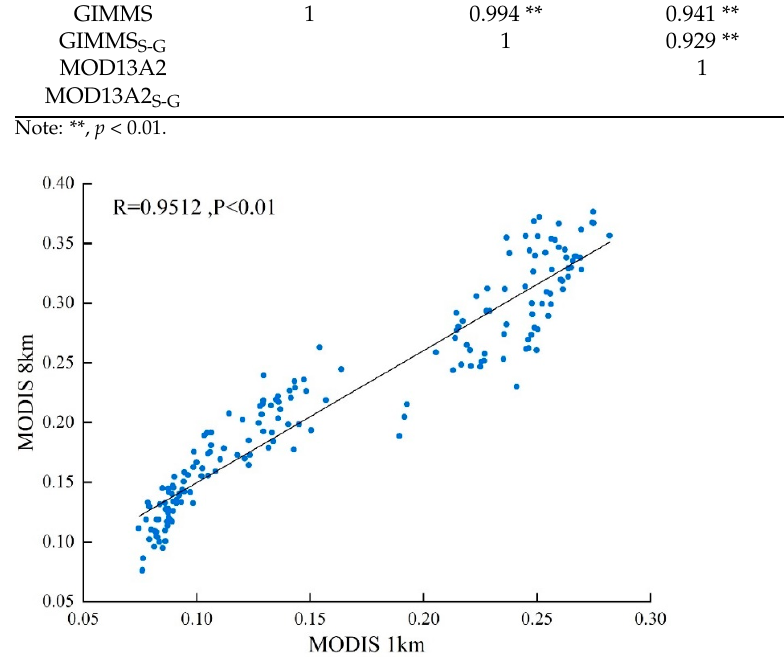
Figure 2. Correlation analysis and linear fitting of MODIS data before and after resample ( p <